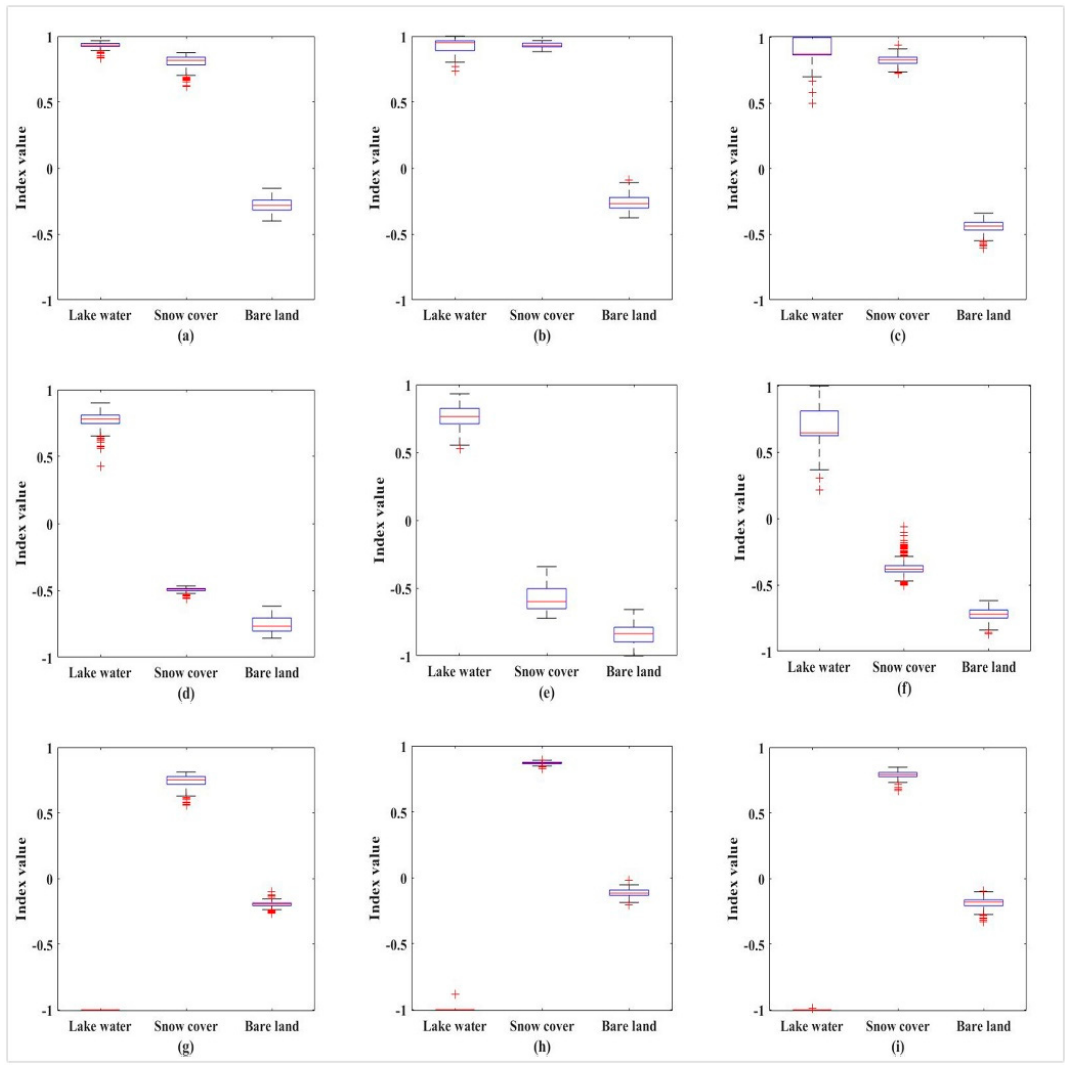
Figure 5. The index values in three study regions based on three hundred sample points. ( a – c ) are the NDSI / MNDWI value in Region I, II and III; ( d – f ) are the NDWI ns value in Region I, II and III; ( g – i ) are the NDSI nw value in Region I, II and